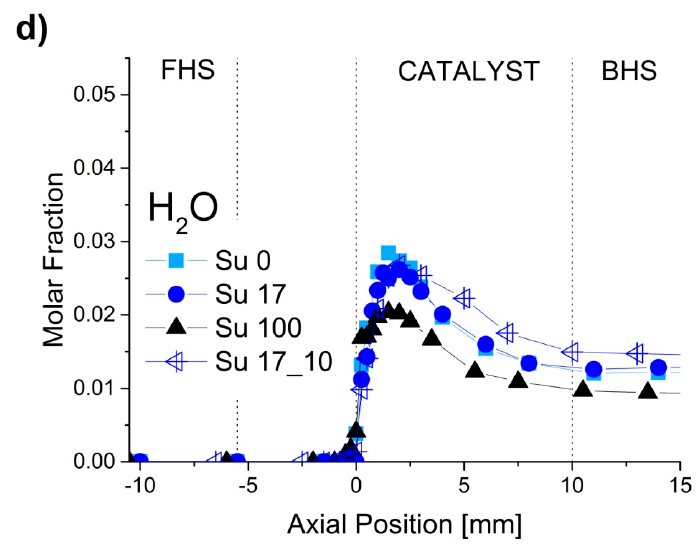
Figure 4. Molar fraction of the products carbon monoxide ( a ); carbon dioxide ( b ); hydrogen ( c ) and water ( d ) as function of the axial coordinate z for the Rh catalyst ( z = 0–10 mm) for CPOX of different surrogates. Along the axial coordinate, the location of the front heat shield (FHS), the catalyst, and the back heat shield (BHS) is indicated.